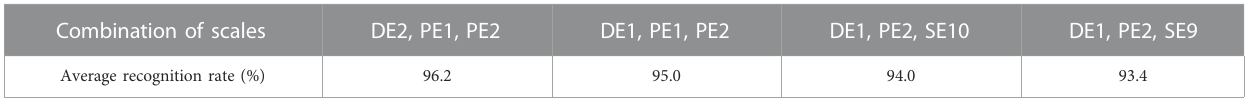
TABLE 3 Triple feature recognition rate for ten types of